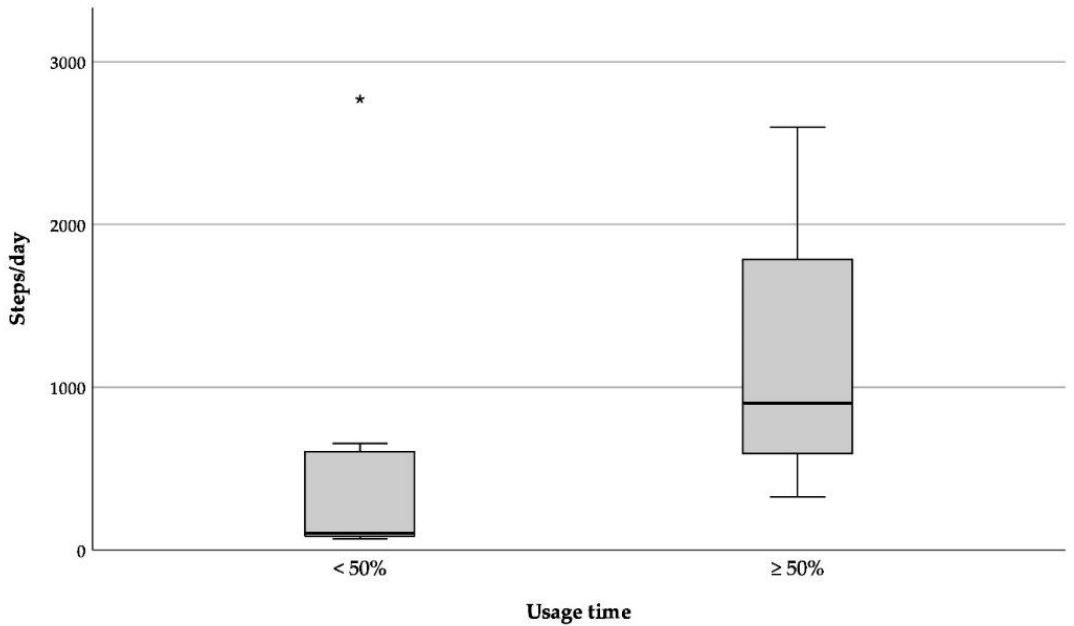
Figure 3. Average of daily steps separated by relative usage time of the Fitbit Zip ( n = 22). * = outlier.